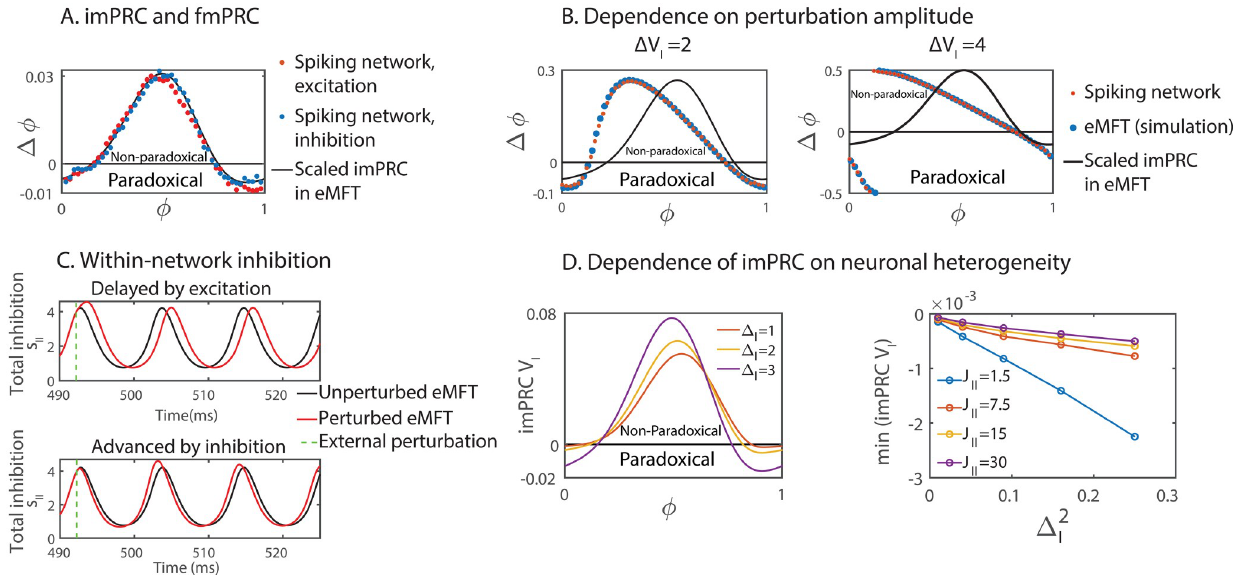
Fig 8. ING rhythms in heterogeneous QIF networks and their eMFT-reduction. (A) The imPRC (black line) of the eMFT multiplied by the signed perturbation strength agreed well with the fmPRCs (orange = excitation, blue = inhibition) from the spiking network simulation. The negative component corresponds to a paradoxical phase response, either a delay for excitation (orange) or an advance for inhibition (blue). (B) Even for strong perturbations, the fmPRC obtained from simulations of the eMFT agreed well with that of the spiking network. (C) As in the IF networks, the paradoxical phase response of the eMFT arose from the paradoxical change in the within-network inhibition. Top: external excitation increased the within-network inhibition. Bottom: external inhibition decreased the within-network inhibition. (D) Left: the amplitude of the paradoxical phase response of the imPRC in the eMFT increased with neuronal heterogeneity. Right: for networks with different synaptic coupling strength J II , the imPRCs of their eMFTs always exhibited a paradoxical phase response for arbitrarily weak neuronal heterogeneity. Parameters: voltage perturbations Δ V were made to the membrane potential or the mean I potential variable V ( t ) with a square-wave pulse of duration 0.02 ms. In (A), Δ V = ± 0.2. In (B), Δ V = 2 (left), Δ V = 4 (right). In (C), Δ V = ± 3. In (A)-(C), I I I I I Δ I =